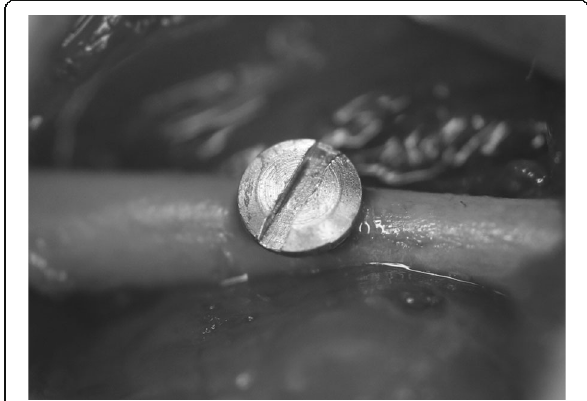
Fig. 4 Implant placement surgery in the femur. A Ti-6Al-4V implant (length 1.0 mm, diameter 0.8 mm) was placed in the Y -axis direction in the center of the femoral shaft